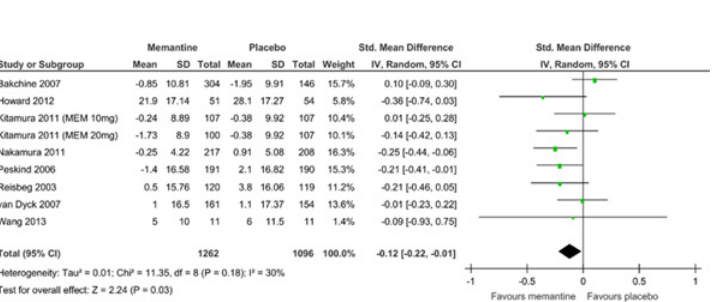
Fig 4. Forest plot of behavioral disturbances (9 comparisons, n = 2358). * Negative SMD values favor memantine; positive SMD values favor placebo. † RR < 1 favors memantine; RR > 1 favors placebo.